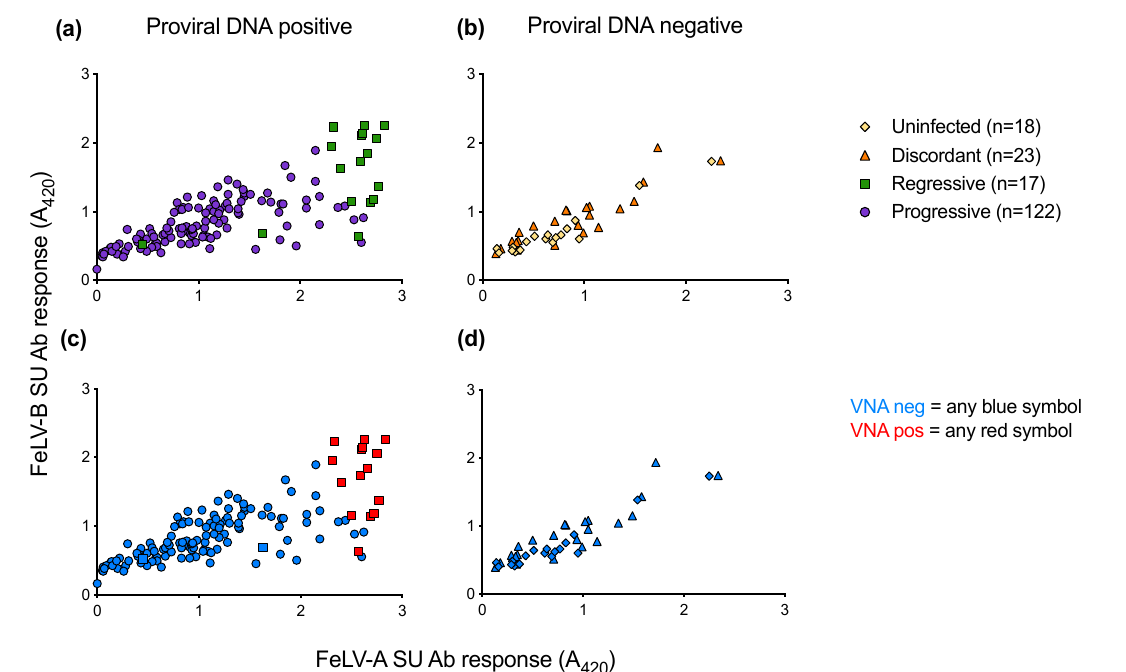
Figure 14. Antibody responses to FeLV-A and FeLV-B SU proteins and VNA responses. Plasma samples were tested for anti-FeLV-A SU and anti-FeLV-B SU antibodies by ELISA. The antibody response to FeLV-A SU is shown on the x-axis, with the antibody response to FeLV-B SU on the y-axis. ( a ) SU antibody responses of PBMC proviral DNA positive samples. ( b ) SU antibody responses of PBMC proviral DNA negative samples. Plasma samples were tested using live virus neutralisation assays to detect VNA ( c ) VNA results of PBMC proviral DNA positive samples. ( d ) VNA results of PBMC proviral DNA negative samples. Only cats with regressive infection displayed VNA (red).